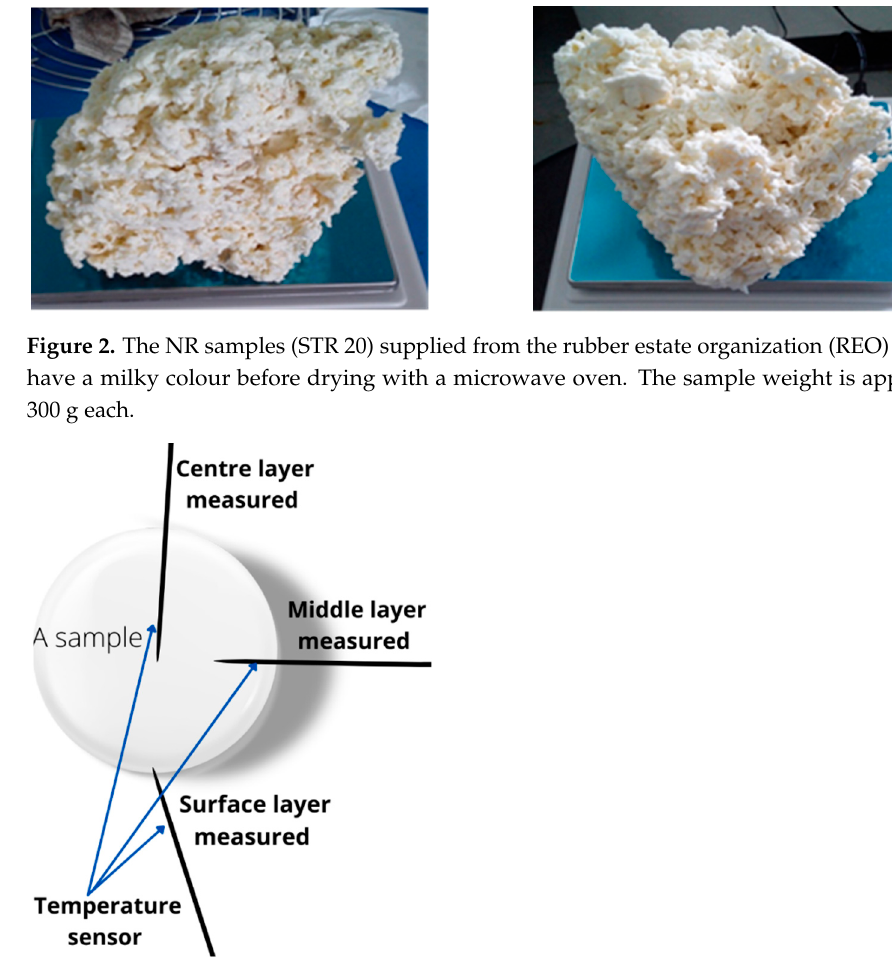
Figure 2. The NR samples ( STR 20 ) supplied from the rubber estate organization ( REO ) of Thailand have a milky colour before drying with a microwave oven . The sample weight is approximately 300 g each .